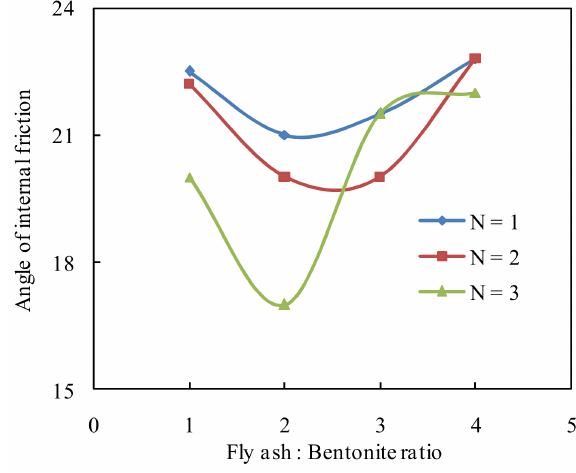
Figure 11. Effective angle of shear resistance values against fly ash–bentonite